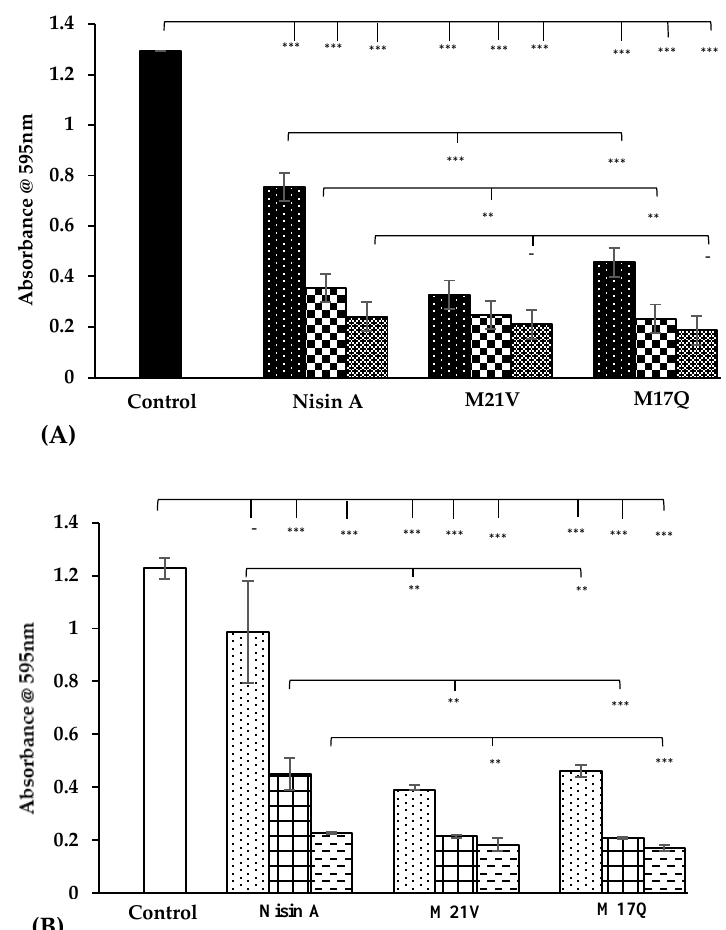
Figure 4. Absorbances of biofilm formed by ( A ) S. epidermidis 28 and ( B ) S. epidermidis 53 on plastic microtiter plates in the presence 1.875 µM, ( , ), 3.75 µM, ( , ) and 7.5 µM, ( , ) nisin A and derivative peptides, M21V and M17Q. Control shows the amount of biofilm produced in the absence of nisin, (